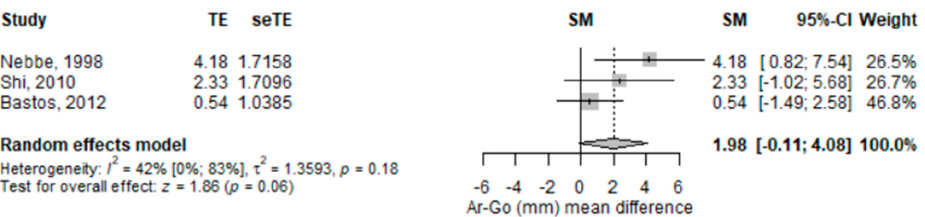
Figure 5. Forest plot for distance from articulare to gonion (mm) standardized mean change differ ‐ ence. Ar ‐ Go—distance from articulare to gonion; TE—effect; seTE—effect’s standard error the ef ‐ fect; SM—the average discrepancy; CI—confidence interval.